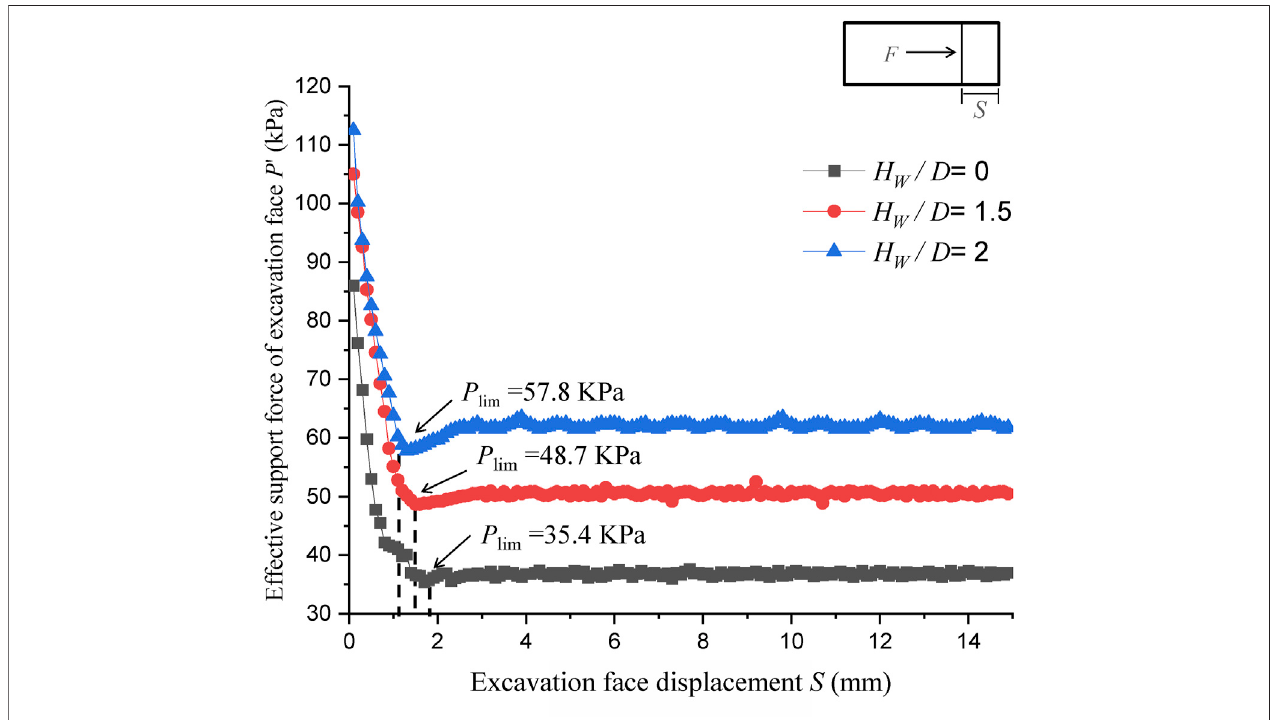
FIGURE 5 | Relationships between limit support pressure and tunneling face displacement under the different head